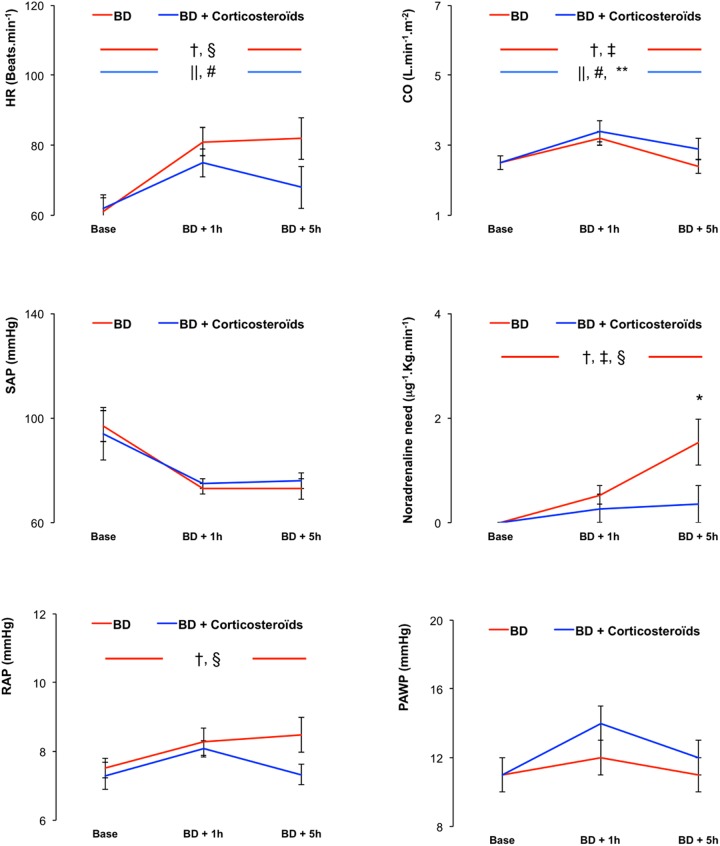
Hemodynamic evaluation.Heart rate (HR), Cardiac output (CO), Mean systemic artery pressure (SAP), Noradrenaline need, Right atrial pressure (RAP), Pulmonary artery wedge pressure (PAWP) in pigs 1 hour and 5 hours after brain death (BD) with placebo-pretreatment (BD group, in red) or with preventive methylprednisolone (BD + Corticosteroids group in blue). Values are expressed as mean ± SEM. * p<0.05 BD versus BD + Corticosteroids; † p<0.05 Base versus BD + 1 hour, ‡ p<0.05 BD + 1 hour versus BD + 5 hours, § p<0.05 Base versus BD + 5 hours in the BD group; || p<0.05 Base versus BD + 1 hour, # p<0.05 BD + 1 hour versus BD + 5 hours, ** p<0.05 Base versus BD + 5 hours in the BD + Corticosteroids group.